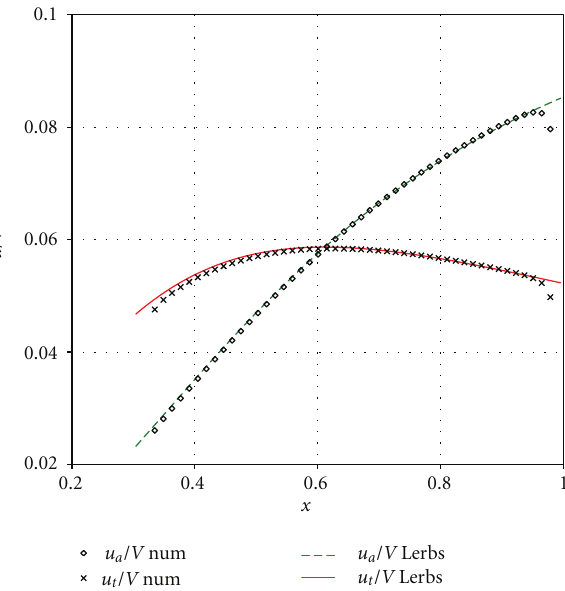
Figure 6: Comparison between predictions of induced velocity components using Lerbs [2] analytical formulation and developed purely numerical lifting line model.